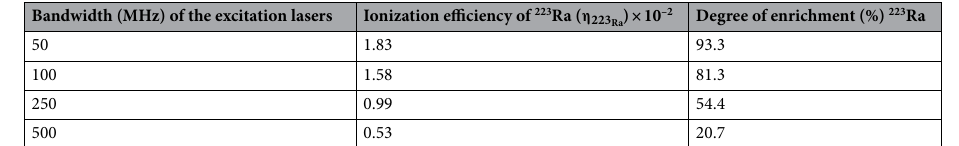
Bandwidth (MHz) of the excitation